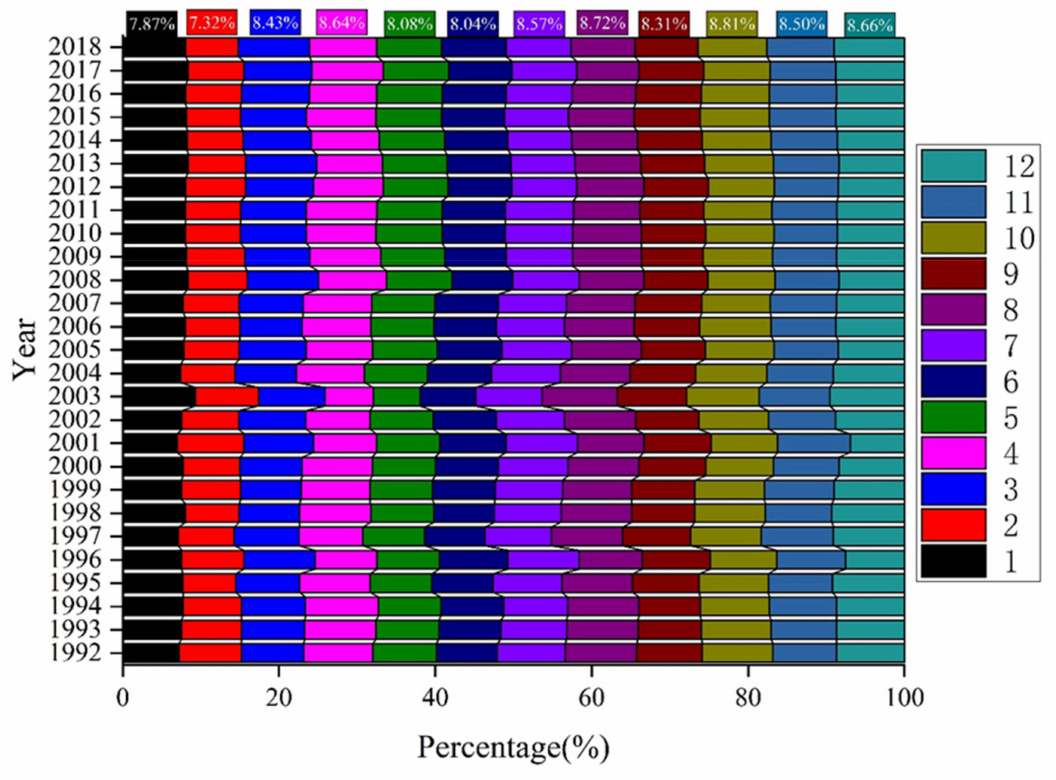
Figure 9. Monthly percentage of inbound tourists in China from 1992 to